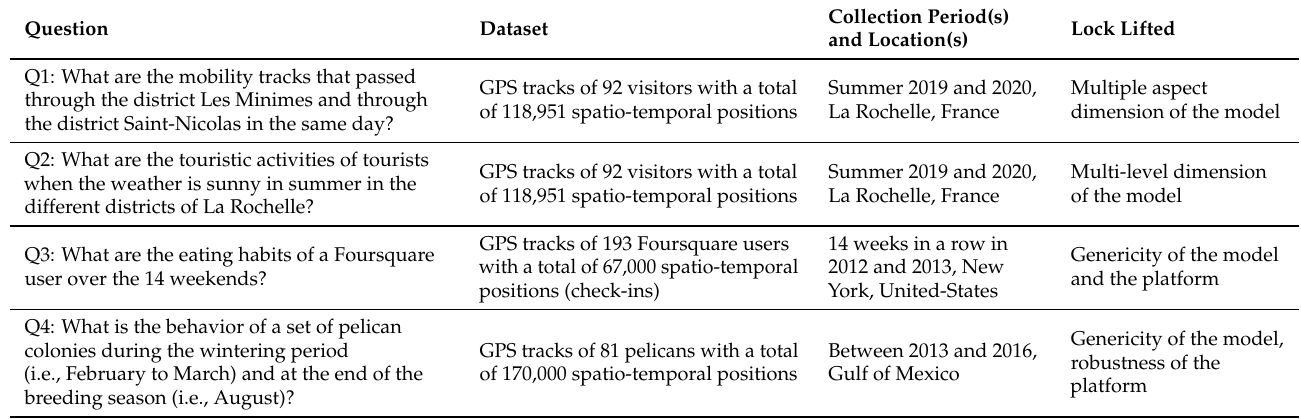
Table 1. Summary of